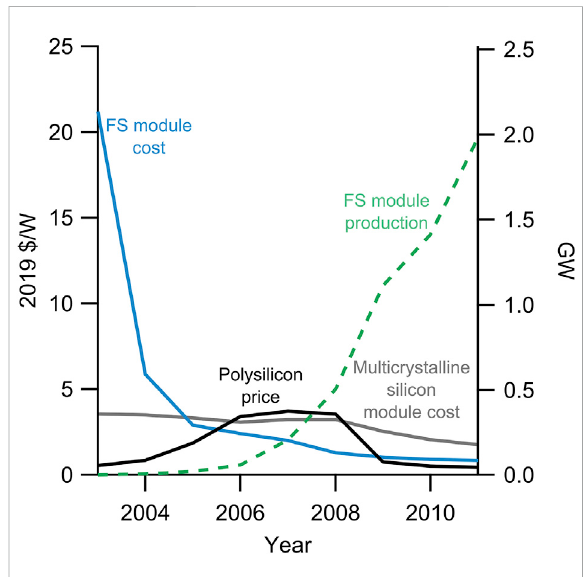
FIGURE 2 First Solar ’ s production, capacity, and manufacturing cost enabled a decrease in module prices to levels lower than silicon module costs during an increase in polysilicon spot prices (which signaled underlying polysilicon market trends), producing a serendipitous window for CdTe module market entry. Cost per watt adjusted to be real values for 2019. Data sources: (Bernreuter Research, 2020; First Solar Inc, 2020; Photon Energy